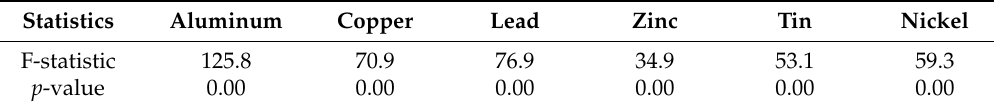
Table 2. Joint hypothesis testing: daily data analysis.